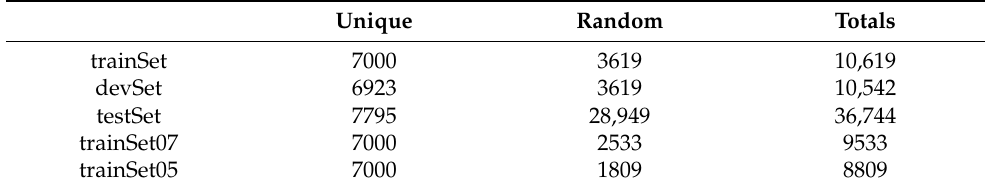
Table 2. Statistics of the datasets divided from